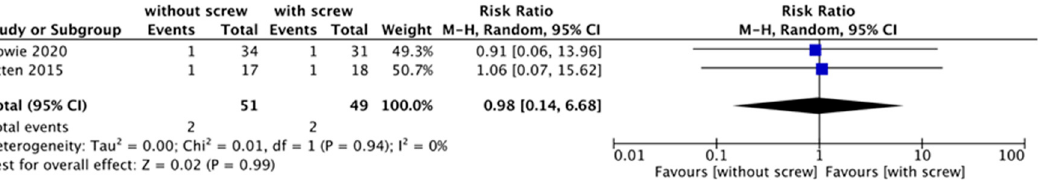
7 of 13 Table 2. Summary of findings. Outcomes